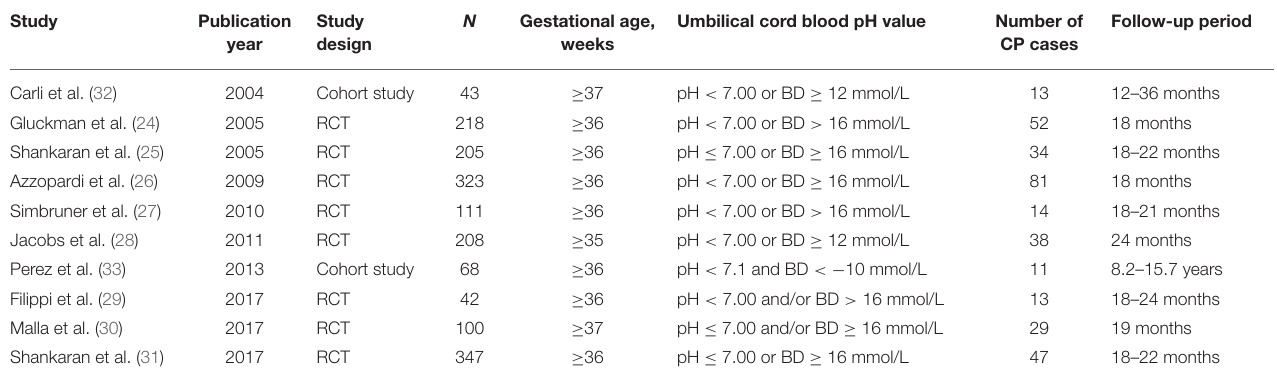
TABLE 1 | Characteristics of the included studies.